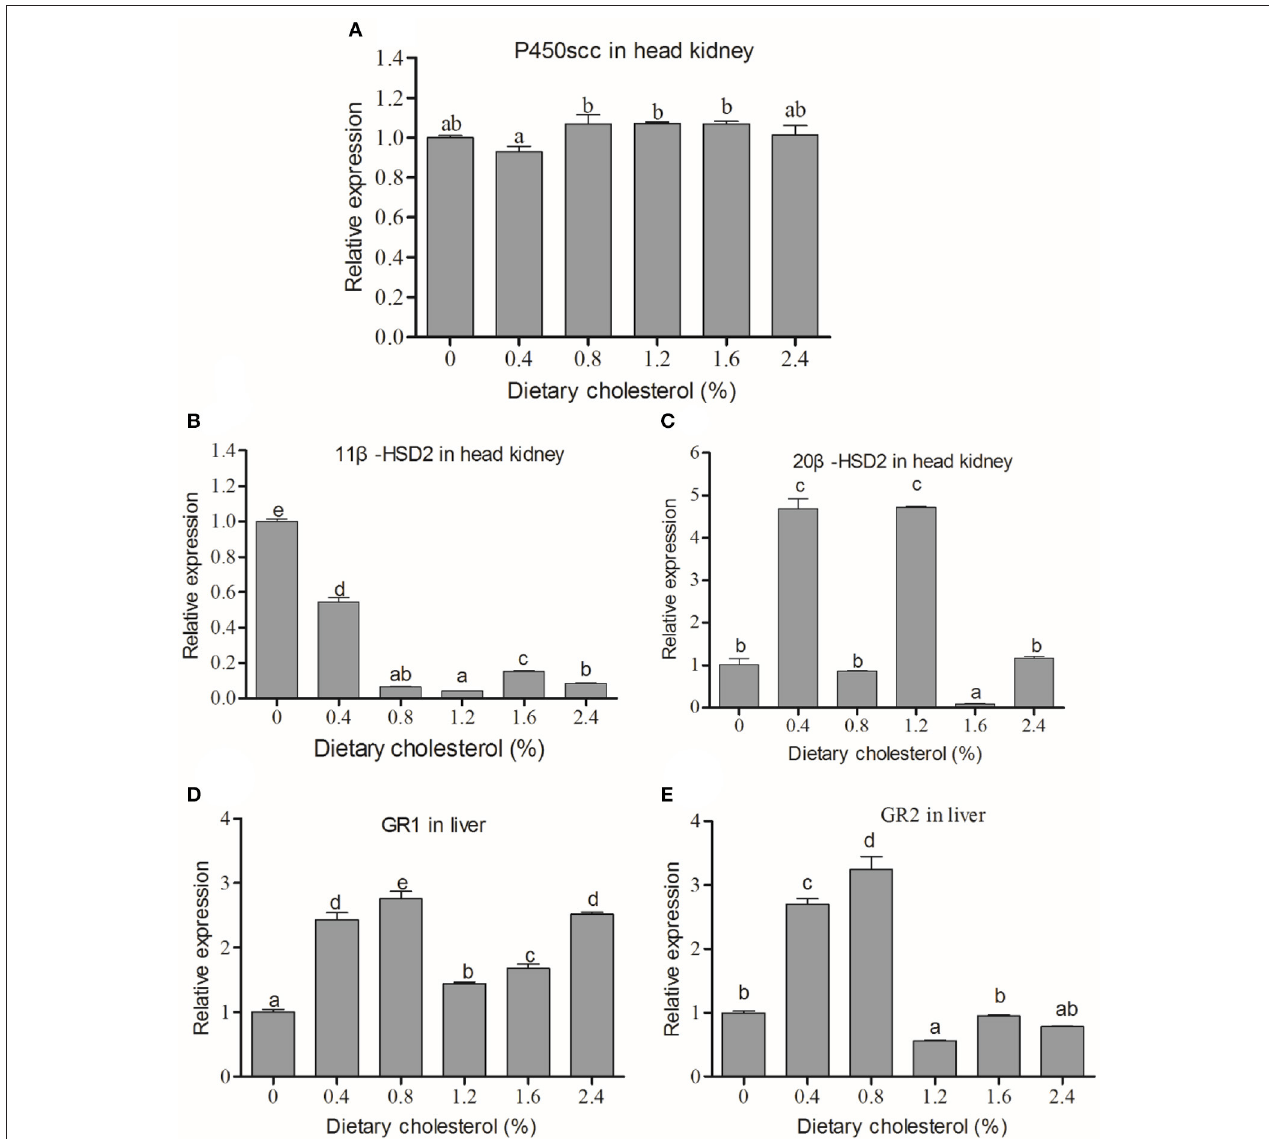
FIGURE 2 | The mRNA expression of key genes in the HPI-axis. (A) The mRNA expression of P450scc in the head kidney; (B) the mRNA expression of 11 β -HSD2 in the head kidney; (C) the mRNA expression of 20 β -HSD2 in the head kidney; (D) the mRNA expression of GR1 in the liver; (E) the mRNA expression of GR2B in the liver. The abscissa indicates the diets, with the different cholesterol percentages labeled 0, 0.4, 0.8, 1.2, 1.6, and 2.4%. The ordinate represents the fold change in the relative gene expression of the three genes in different groups relative to the 0% cholesterol group. The different lowercase letters represent significant differences among groups ( P < 0.05). Values (mean ± S.E.) of the mRNA expression levels are the mean of nine